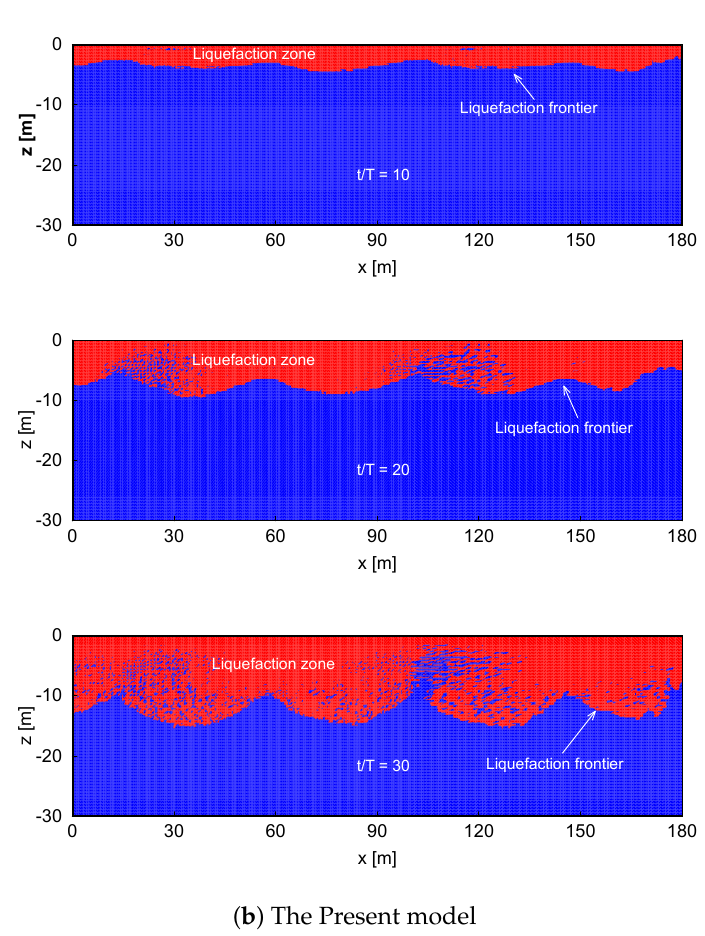
Figure 7. Liquefaction process in a sandy seabed according to ( a ) the original PZIII (Pastor–Zienkiewicz Mark-III) model and ( b ) the present